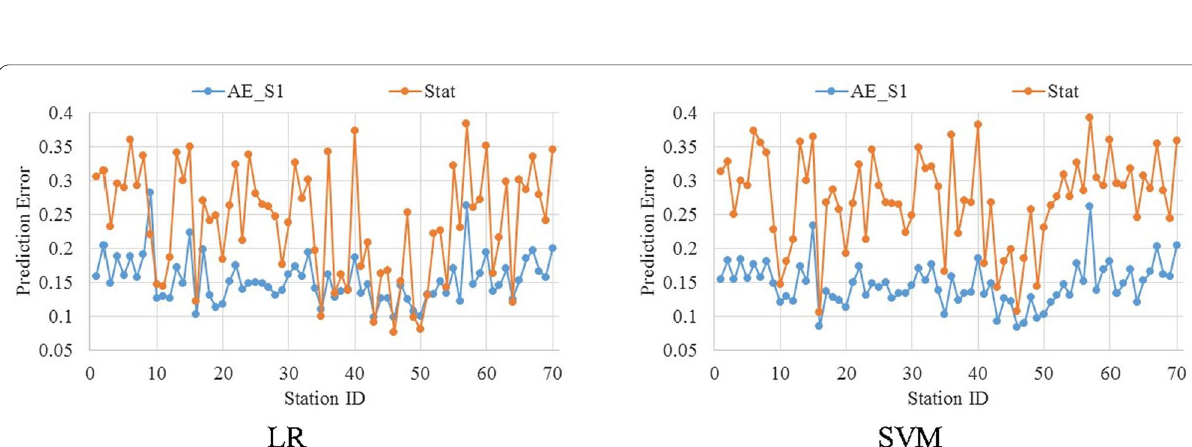
Fig. 6 Comparison of day-ahead prediction error between SAE stage 1 and stat features. Table 2 in appendix details the empirical results